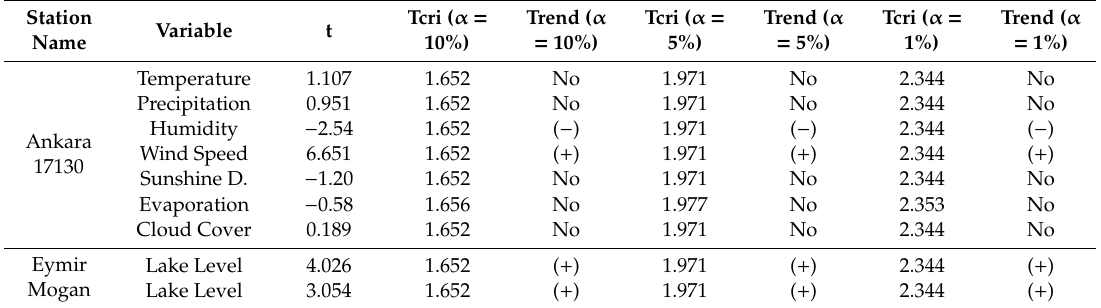
Table 5. LT method results.